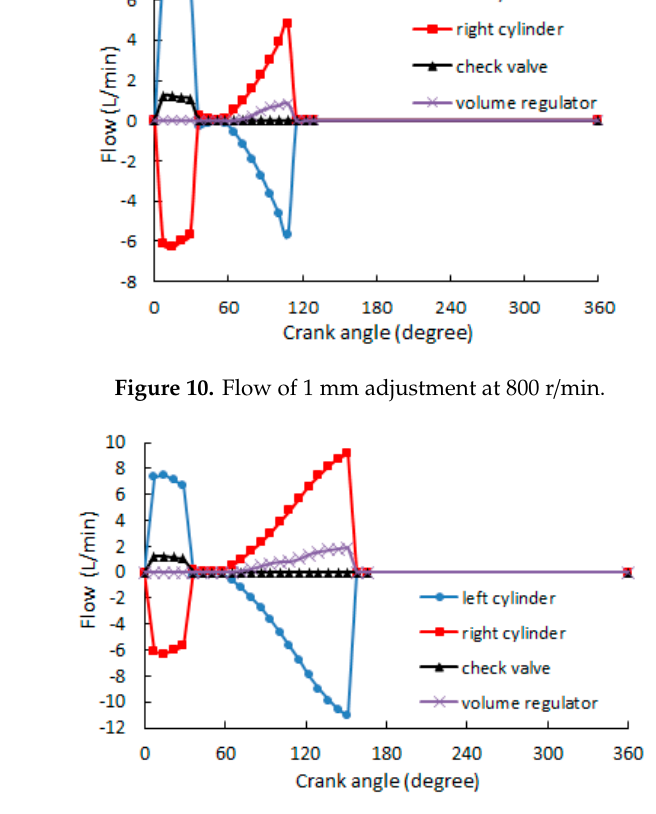
Figure 11. Flow of 4 mm adjustment at 800 r/min.